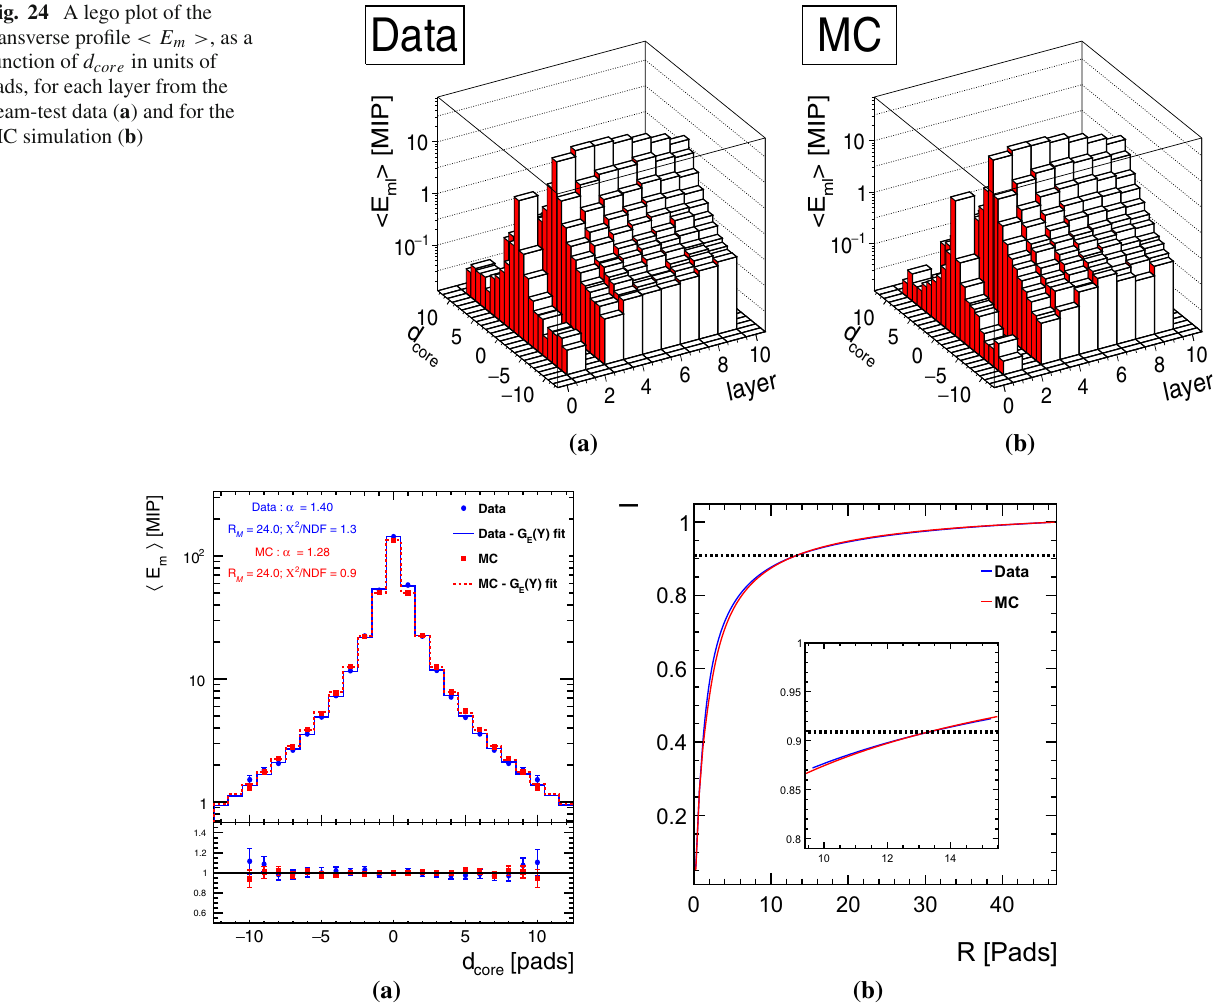
Fig. 25 a Theshowertransverseprofile < E m > ,asafunctionof d core in units of pads, of the joint distribution of all three configuration from beam-test data and the MC simulation, after symmetry corrections and fit. The lower part of the figure shows the ratio of the distributions to the